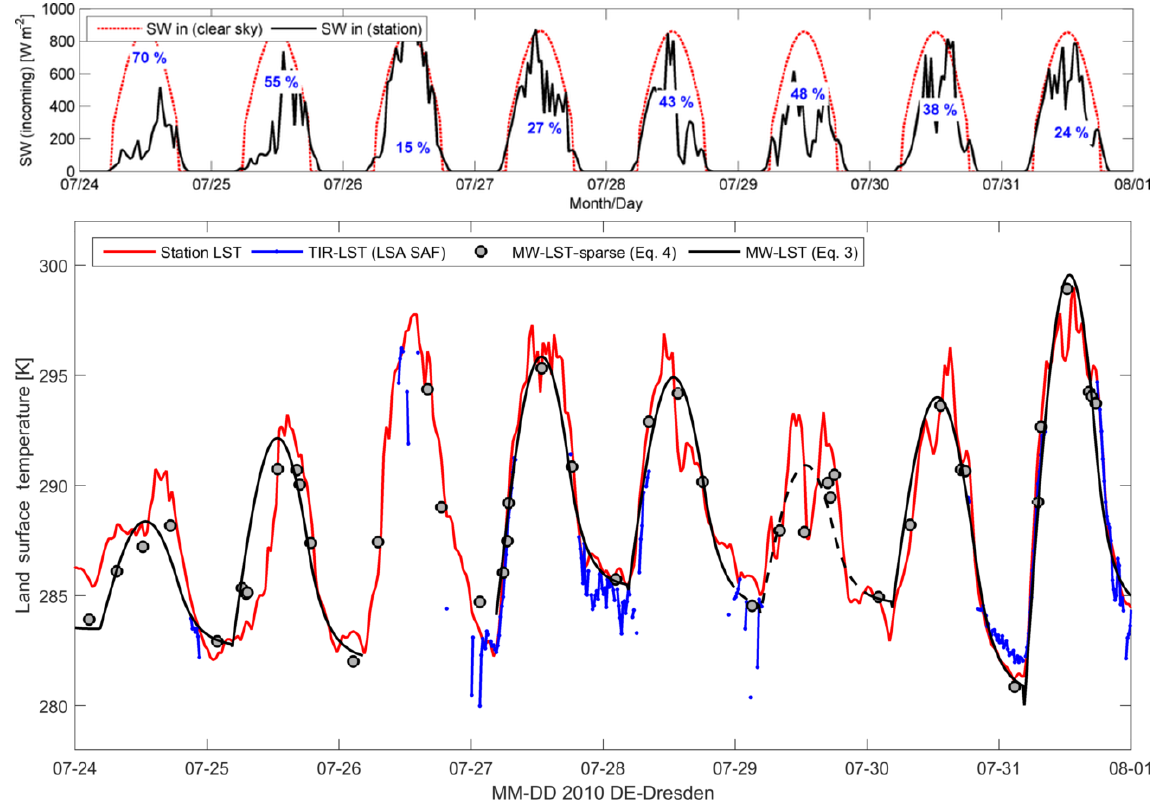
Figure 1. An example of the available data at station B, showing 8-day time series of station-measured shortwave incoming radiation ( S ↓ , or SW, top) and LST (bottom graph). In the top graph S ↓ (black lines) is compared to the clear-sky expected value, S to illustrate the computation of the cloud cover proxy ( A cloud , Eq. 8, values in blue text). In the lower graph the station LST is compared to the TIR and MW satellite LST products. The dashed line is an occurrence where the MW-LST is masked due to a high misfit between sparse observations and the diurnal